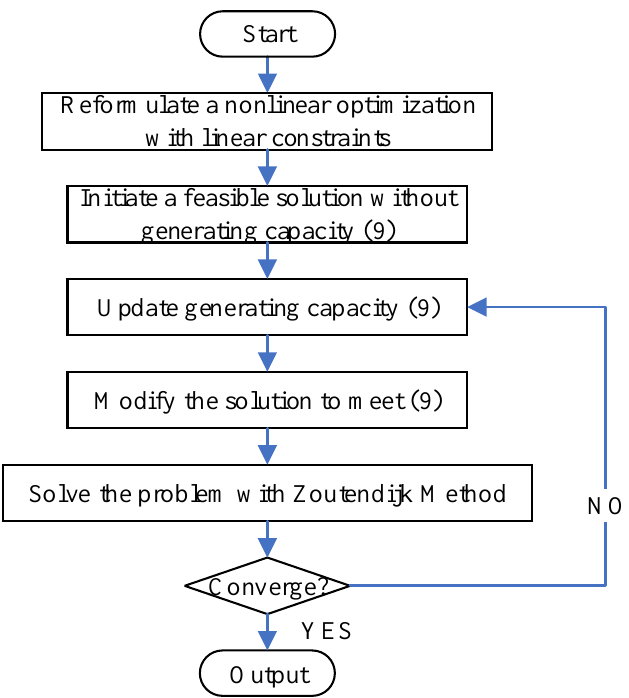
Figure 1. High-level flowchart of the solution procedure.